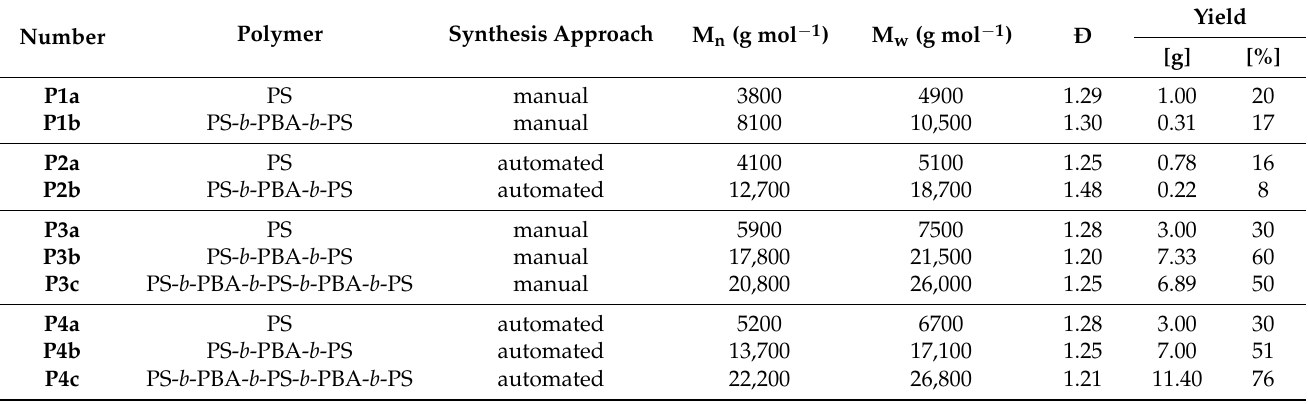
Table 1. Summary of the molar masses of the synthesized polymers P1 – P4 (the molar masses were determined using SEC; standard: Polystyrene; solvent: Chloroform/isopropanol/triethylamine